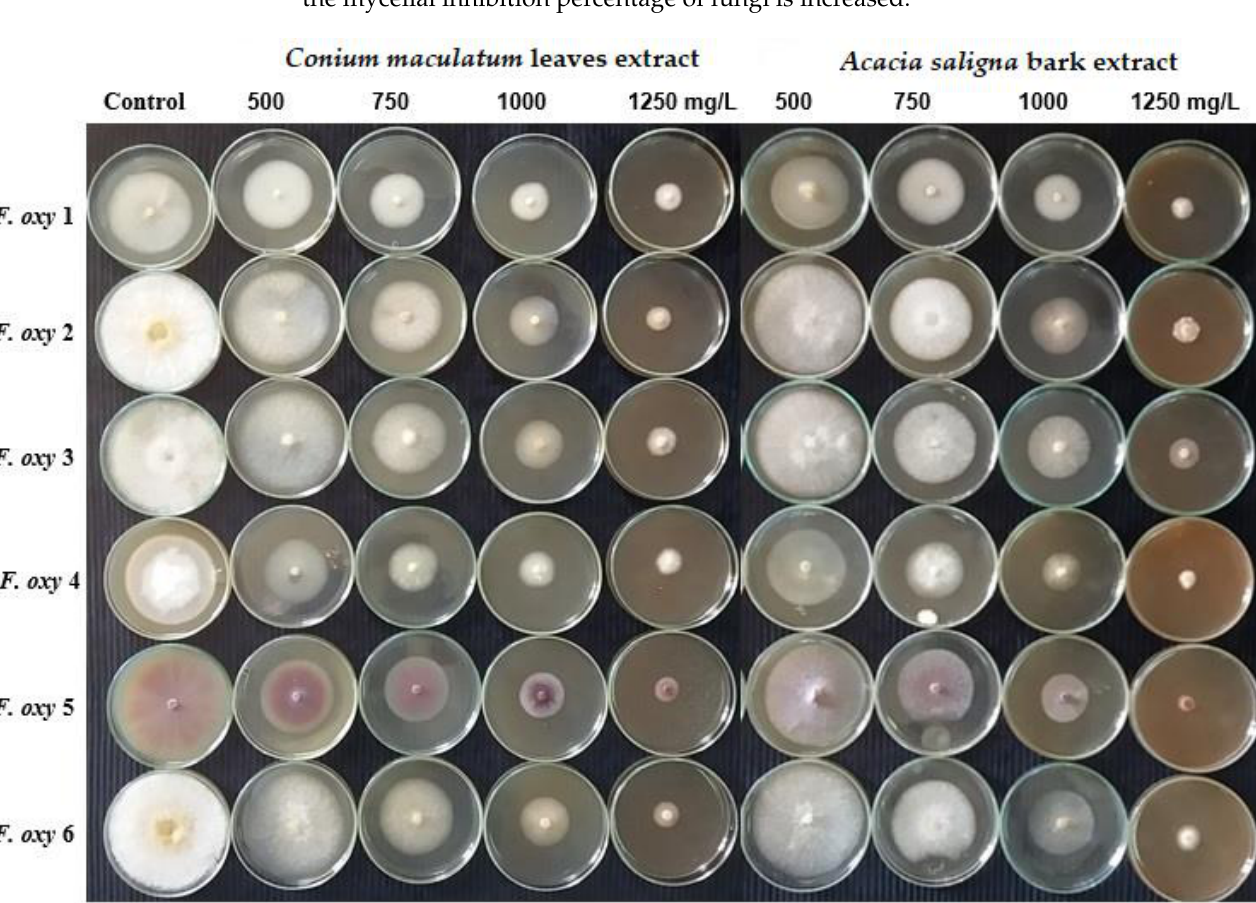
Figure 1. HPLC analysis of extracts from ( a ) Conium maculatum leaves ; ( b ) Acacia saligna bark; ( c ) Schinus terebinthifolius wood; and ( d ) Ficus eriobotryoides leaves.